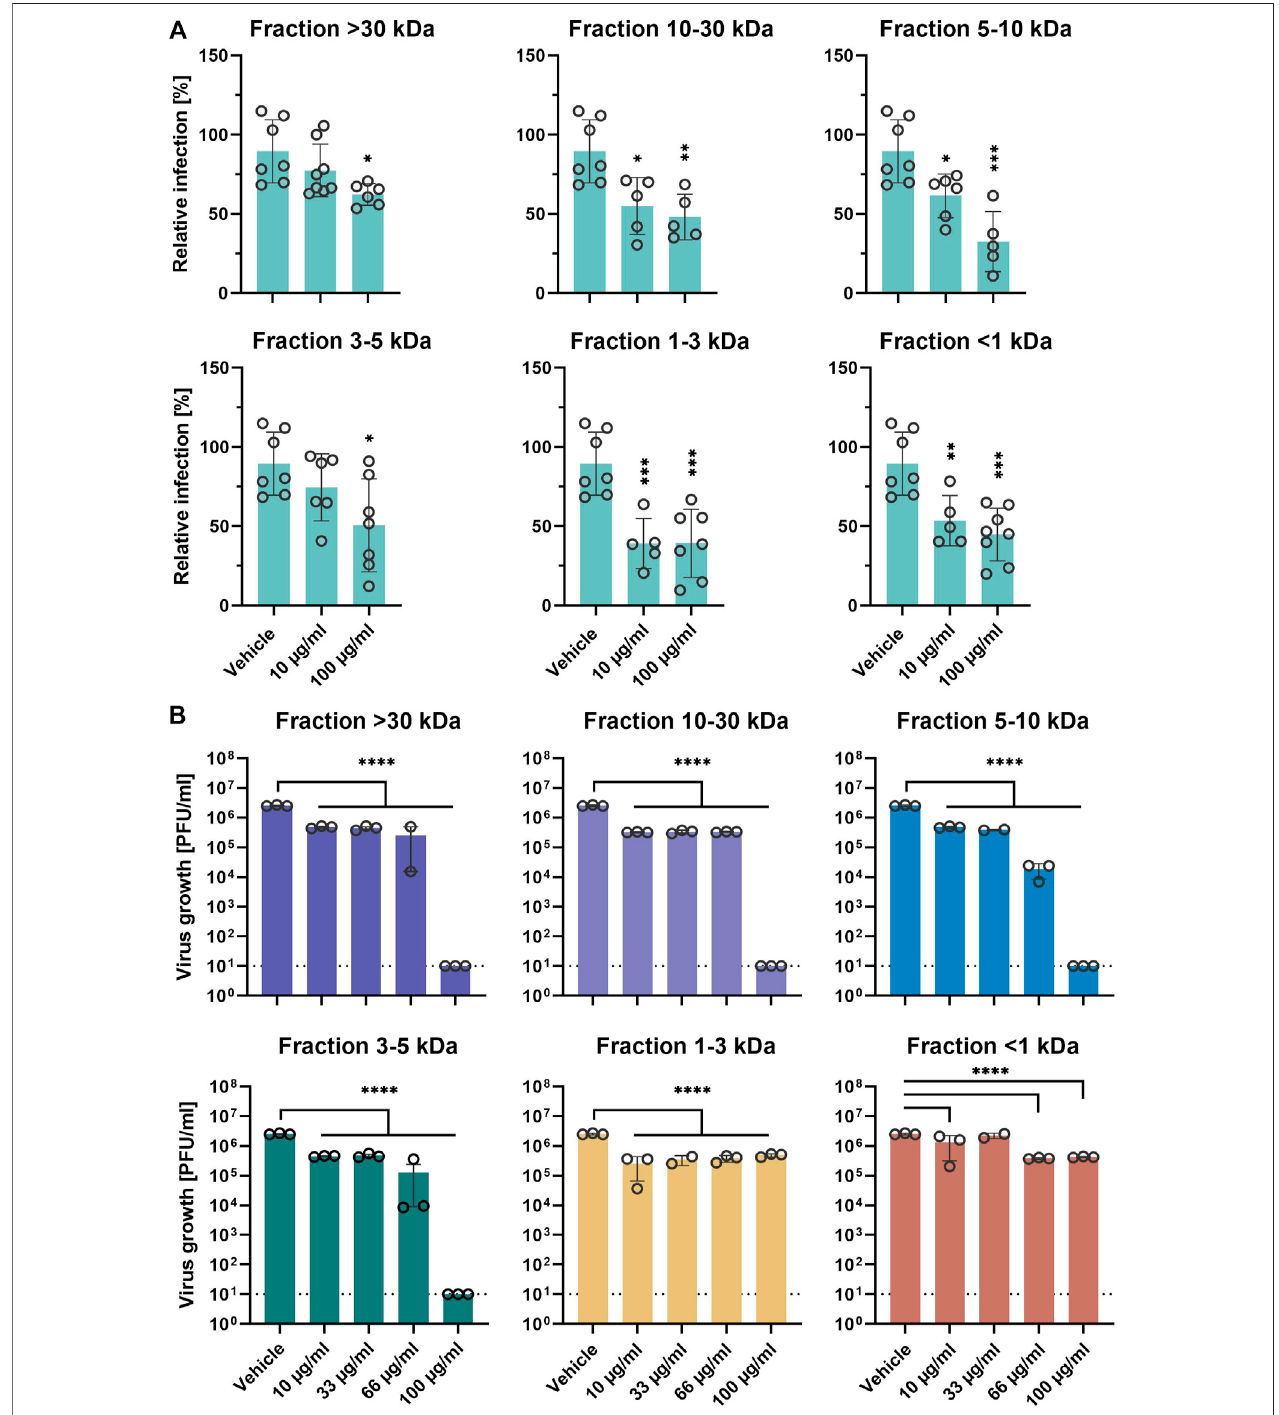
FIGURE4 | EPs 7630 molecular fractions differentially inhibit SARS-CoV-2 propagation. (A) Infection ofCalu-3cells with SARS-CoV-2-Spike VSVpp (SARS-CoV- 2-S) or VSV-G as control was done in the presence of compounds for 30 min at 4 ° C at 500 × g followed by 1-h incubation at 37 ° C. Cell lysates were prepared after 24 h and the luciferase signal was measured using a multi-mode 96-well plate reader. Bars represent mean values and SD from n (cid:2) 5 – 8 biological samples from two independent experiments. Technical outliers were removed from the analysis. (B) Calu-3 cells were infected with SARS-CoV-2 (MOI (cid:2) 0.0005) and treated with fractions ofultra fi ltrated EPs 7630simultaneously. Virus-containing supernatantswere collected 48h post-infection and viral titers were determined asplaque-formingunits (PFU)/mlbyplaquetitrationassay.Dataarederivedfrom n (cid:2) 3biologicalsamples(for < 30kDa66 μ g/ml,5 – 10kDa33 μ g/ml,1 – 3kDa33 μ g/ml,and < 1kDa33 μ g/ml: n (cid:2) 2). Vehicle medium. Statistical signi fi cance (treatment vs. vehicle) is indicated by (*) as determined by two-way (A) or one-way (B) ANOVA with Dunnett ’ s multiple comparison testing. Asterisks are shown only for signi fi cantly different data sets in comparison to vehicle treatment. (*) (cid:2) p < 0.05; (**) (cid:2) p < 0.01; (***) (cid:2) p < 0.001; (****) (cid:2) p < 0.0001.